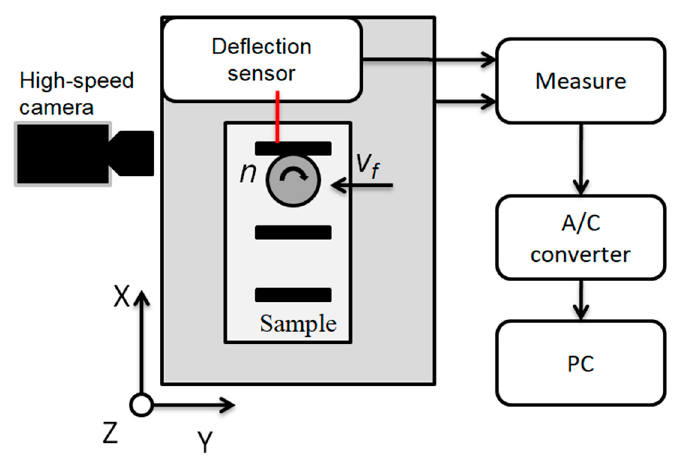
Figure 2. Experimental setup.